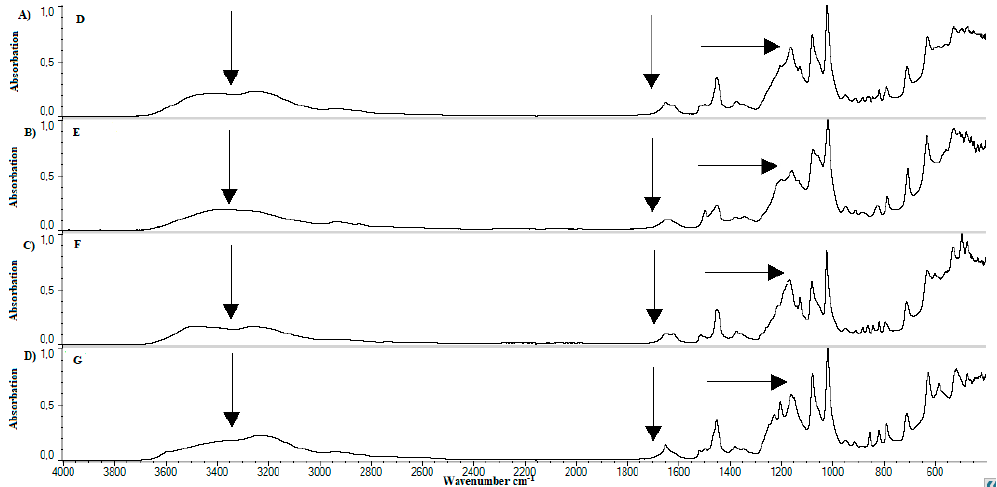
Figure 9. Comparison of Spectrum FTIR for samples D–G. ( A ) Sample D; ( B ) sample E; ( C ) sample F; ( D ) sample G.